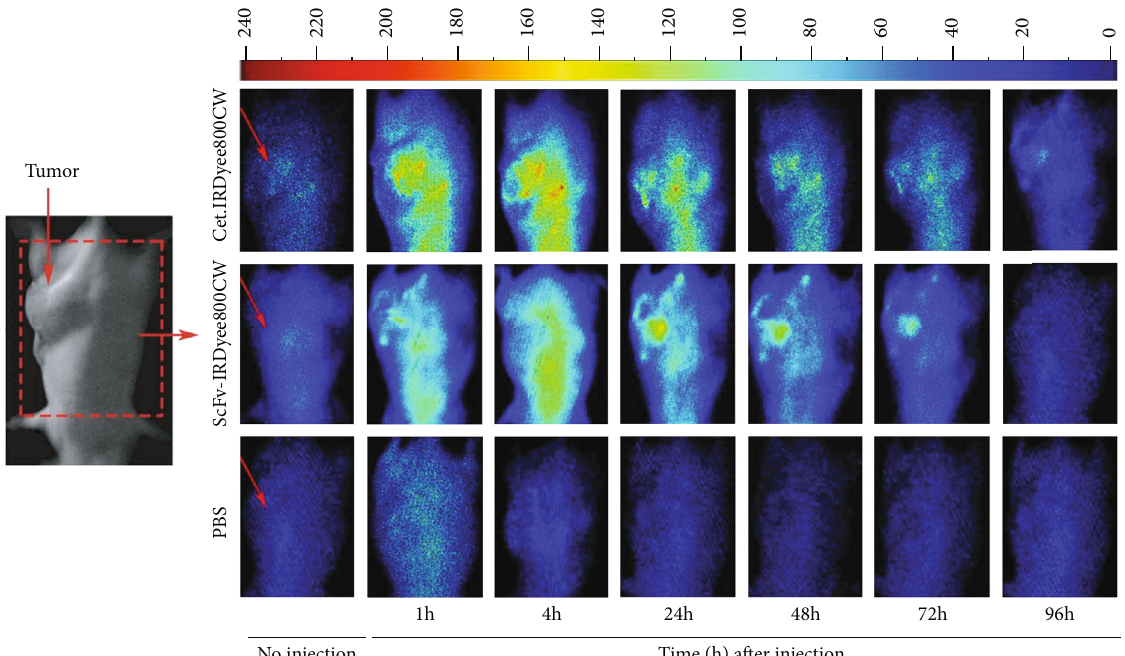
Figure 6: NIR fl uorescence imaging of U-87 MG-bearing mice after injection of IRDye800CW-conjugated antibodies. Degree of labeling and amount of injection are the same as described in the Figure 4 caption.